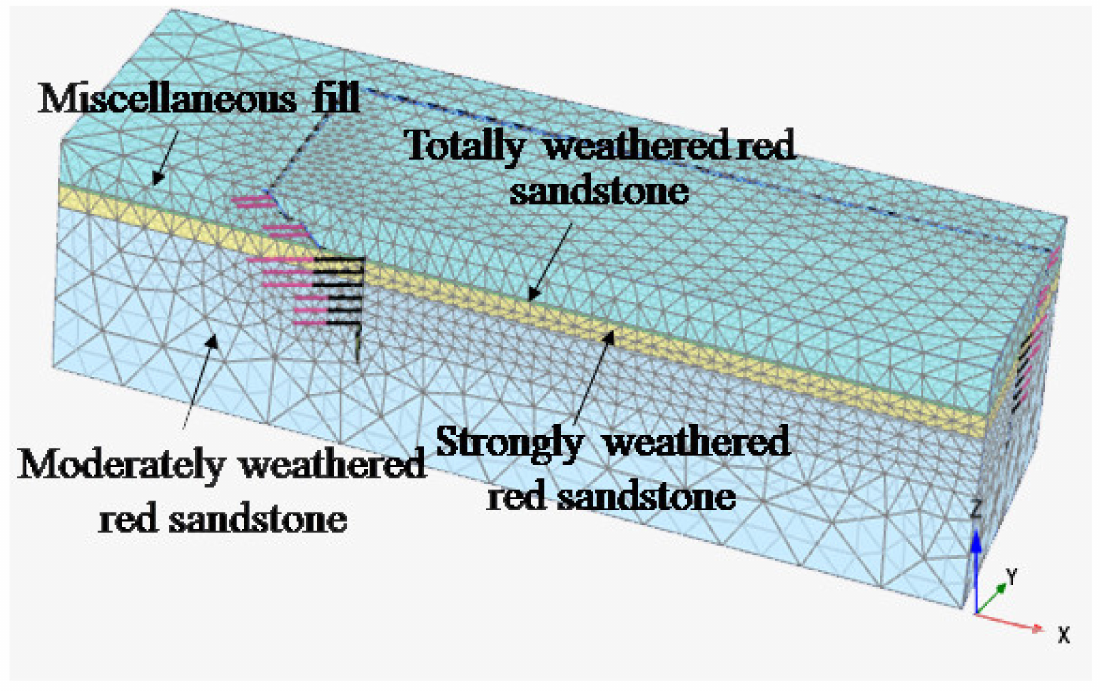
Figure 11. 3D mesh of the model.